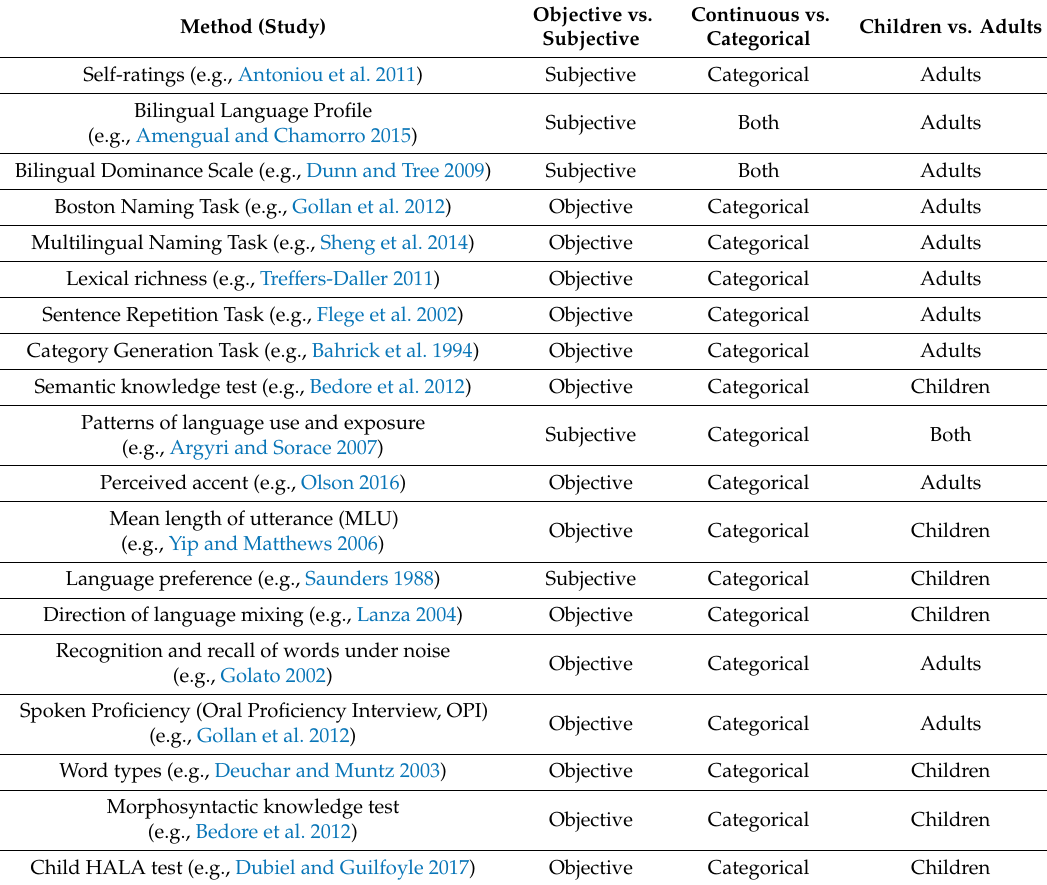
Table 1. Language Dominance Assessments 1